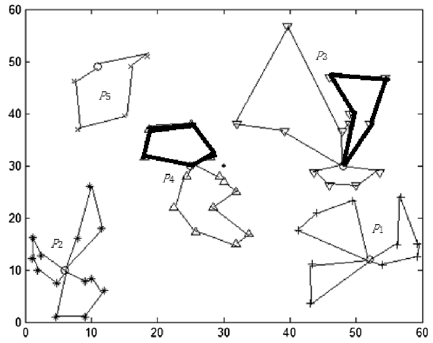
Figure 4. Distribution route selected by TP based on DRO.